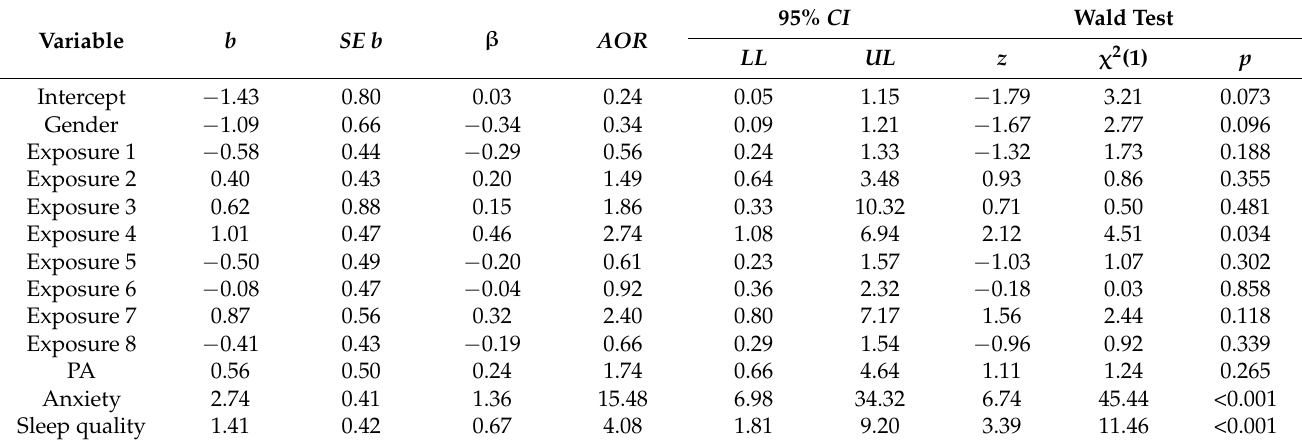
Table 3. Results of logistic regression analysis for depression.